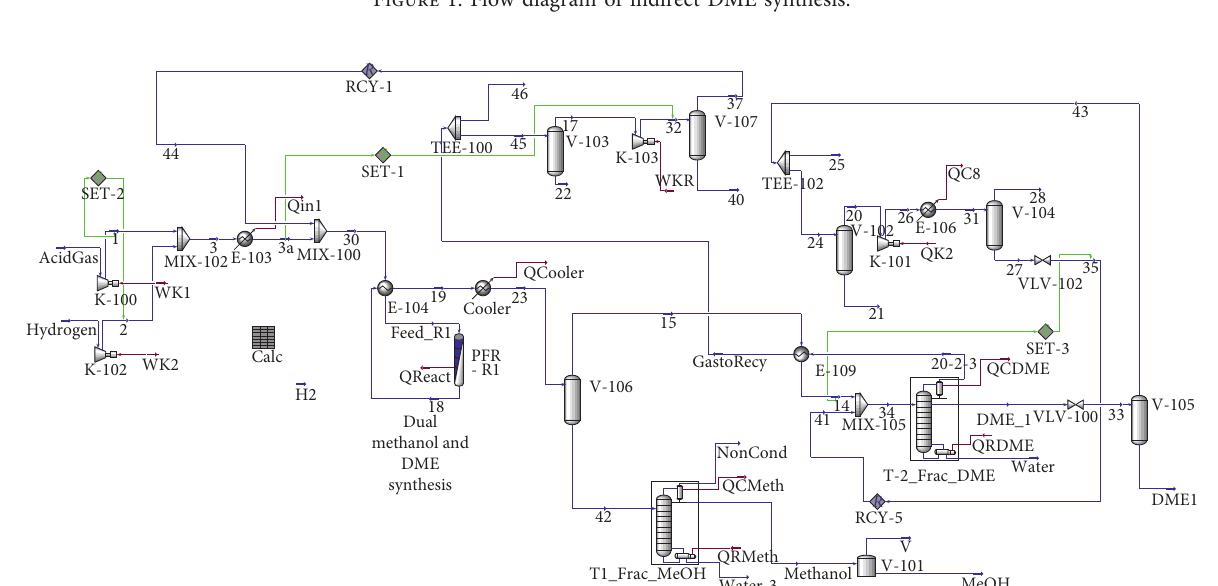
Figure 1: Flow diagram of indirect DME synthesis.